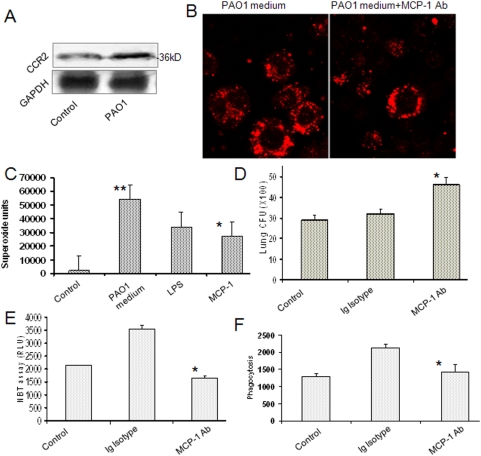
MCP-1 receptor was increased along the enhanced immune function and MCP-1 antibody alleviated the infection.(A) The receptor of MCP-1 (CCR2/CKR2) was also increased in AECII by PAO1 infection detected with western blotting. (B) CCR2 expression following PAO1 infection was reduced by pre-incubating with MCP-1 antibodies (30 min) and determined by immunofluorescence. (C) Increase in superoxide release was measured using H2DCF by direct addition of the commercially available MCP-1 peptide. (D) BAL CFU from mice was increased by neutralizing antibodies against MCP-1 before PAO1 infection. (E) Superoxide was reduced in the AM from mice following instillation of MCP-1 antibodies as measured by NBT assay. (F) The AM from the same mice also demonstrated decreased phagocytosis ability. Statistical analysis was performed as above (** p<0.01, 99% CI). The results are representative of three experiments.